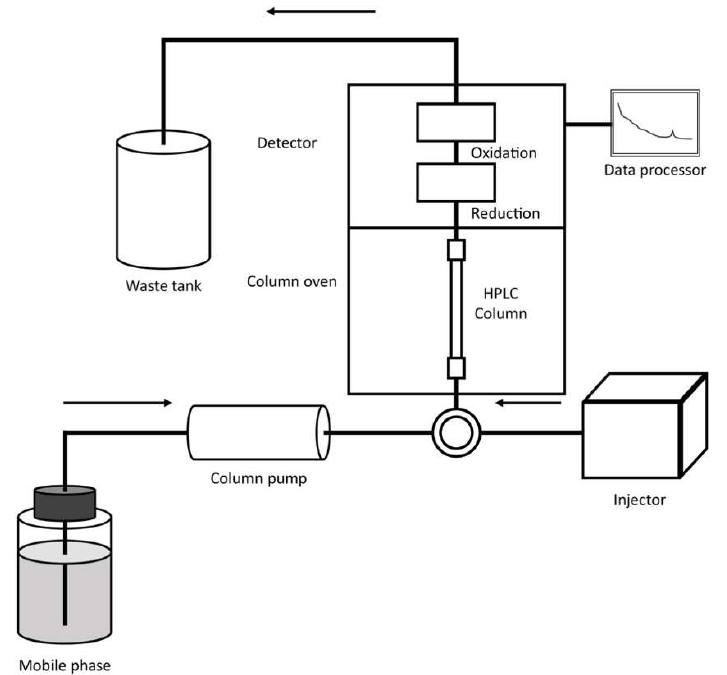
Figure 6. Schematic diagram of the HPLC-ECD system (Reprinted with permission from Ref. [33]. Copyright 2019 Journal of Visualized